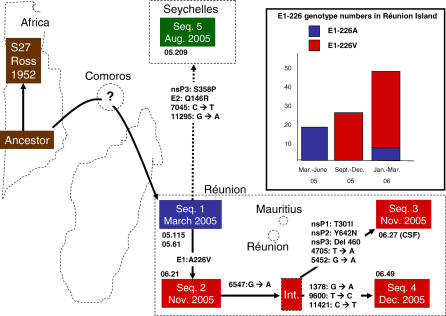
Proposed Evolutionary Scenario of CHIKV Isolates from the Indian Ocean OutbreakThe scenario is based on six genome sequences determined by direct sequencing of RT-PCR products obtained using RNA extracts as templates; the sequences (Seq.) thus correspond to consensus sequences of the possible mixture of coexisting genomes (quasispecies).Inset: number of cases of E1-226A and E1-226V at different time intervals in Réunion Island, based on partial E1 sequences. E1-226V was observed in consensus sequences 2, 3, and 4, and therefore most E1-226V isolates genotyped based on partial E1 sequences are likely related to these genotypes. However, the independent appearance of E1-226V in other genotypes cannot be excluded. The location, size, and relative position of the islands and the African border are indicative. Consensus sequence 1 was obtained from a Réunion patient who travelled back from Comoros in March 2005, and from a Réunion Island patient. Sequences 2–4 were sampled in Réunion Island; sequence 5 was sampled in the Seychelles. The strain codes are given under the corresponding sequences. The question mark in Comoros Archipelago indicates that Sequence 1 possibly originates from Comoros. The dotted link between Sequence 1 and Sequence 5 indicates that the transmission route is hypothetical.CSF, cerebrospinal fluid; Int., deduced intermediate sequence, which was not sampled.